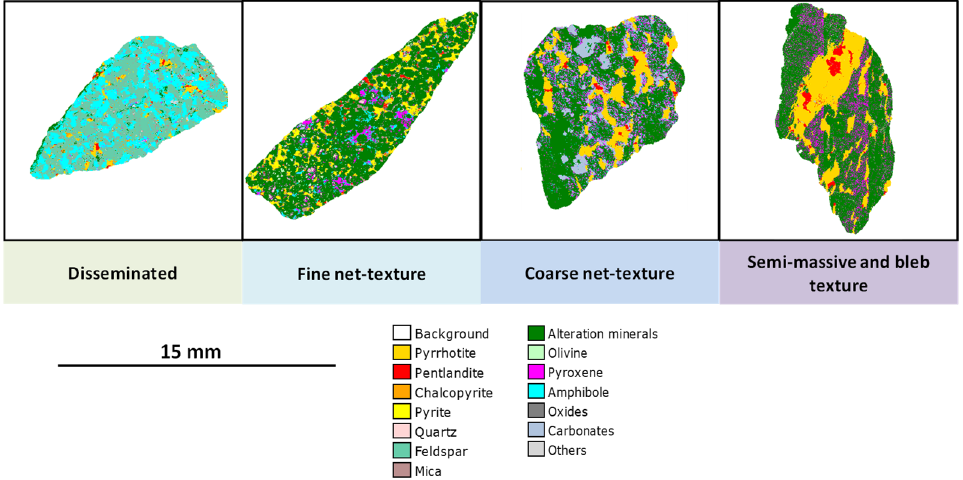
Figure 7. Selected false colour particle images of ore A mapped by QEMSCAN, showing observed sulfide textures and corresponding changes in grain size.